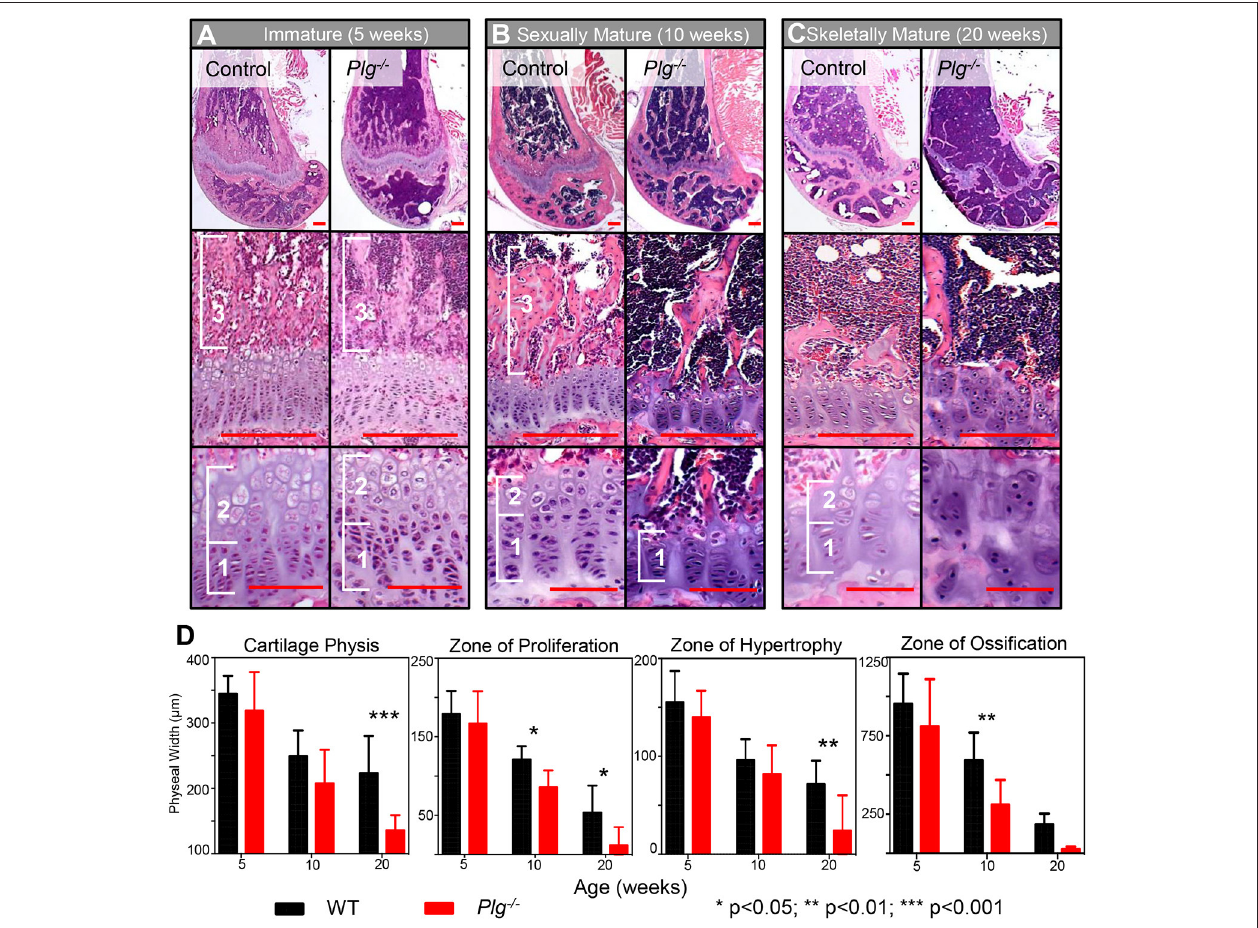
FIGURE 2 | Impaired fibrinolysis, as a result of a plasminogen deficiency, results in postnatal physeal abnormalities and early cessation of skeletal growth. Histological evaluation of the distal femur of Plg − / − and WT mice during (A) immature (5 weeks), (B) sexually mature (10 weeks), and (C) skeletally mature (20 weeks) growth phases. Physeal zones are demarcated with white brackets (1, zone of proliferative; 2, zone hypertrophy; and 3, zone of ossification). No apparent differences in zone sizes or organization were observed in WT and Plg − / − mice during immature skeletal development. In contrast, Plg − / − mice in the sexually mature and skeletally mature growth phases showed reduced widths of the proliferative and hypertrophic zones in comparison to WT age-matched mice. Additionally, the physis of Plg − / − mice during both of these growth phases was markedly disorganized, indicating premature cessation of growth [H&E, Top Panel: 2.5 × magnification (red scale bars, 100 µ m); Middle Panel: 20 × magnification (red scale bars, 25 µ m); Bottom Panel: 40 × magnification (red scale bars, 100 µ m)]. (D) Quantification of physeal zones in wild type and Plg − / − mice during skeletal development. Measurement of cartilaginous physis, zone of hypertrophy, zone of proliferation, and zone of ossification